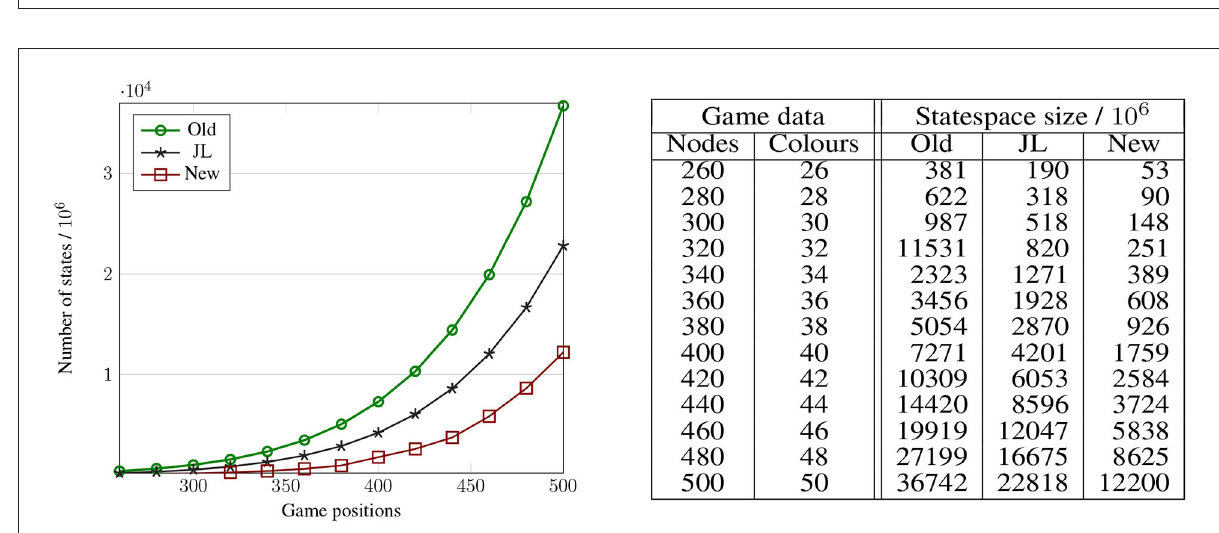
FIGURE2 Size of the statespace for games with a linear number of colors on a linear